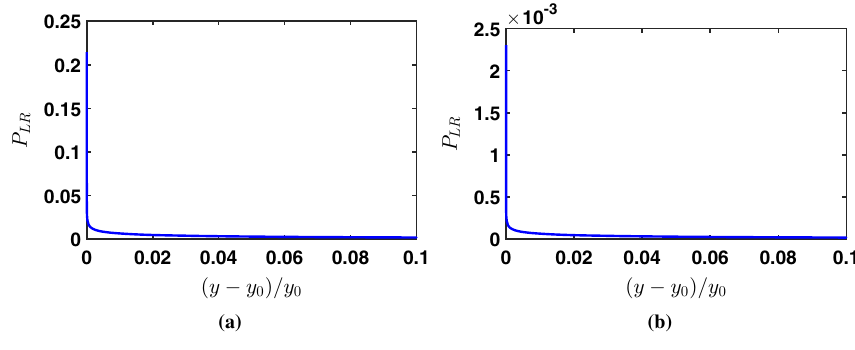
Fig. 1 The transition probability P LR of spin oscillations versus the dimensioless impact parameter y for neutrinos scattering off a Schwarzschild BH for different neutrino energies. a E = 10 m